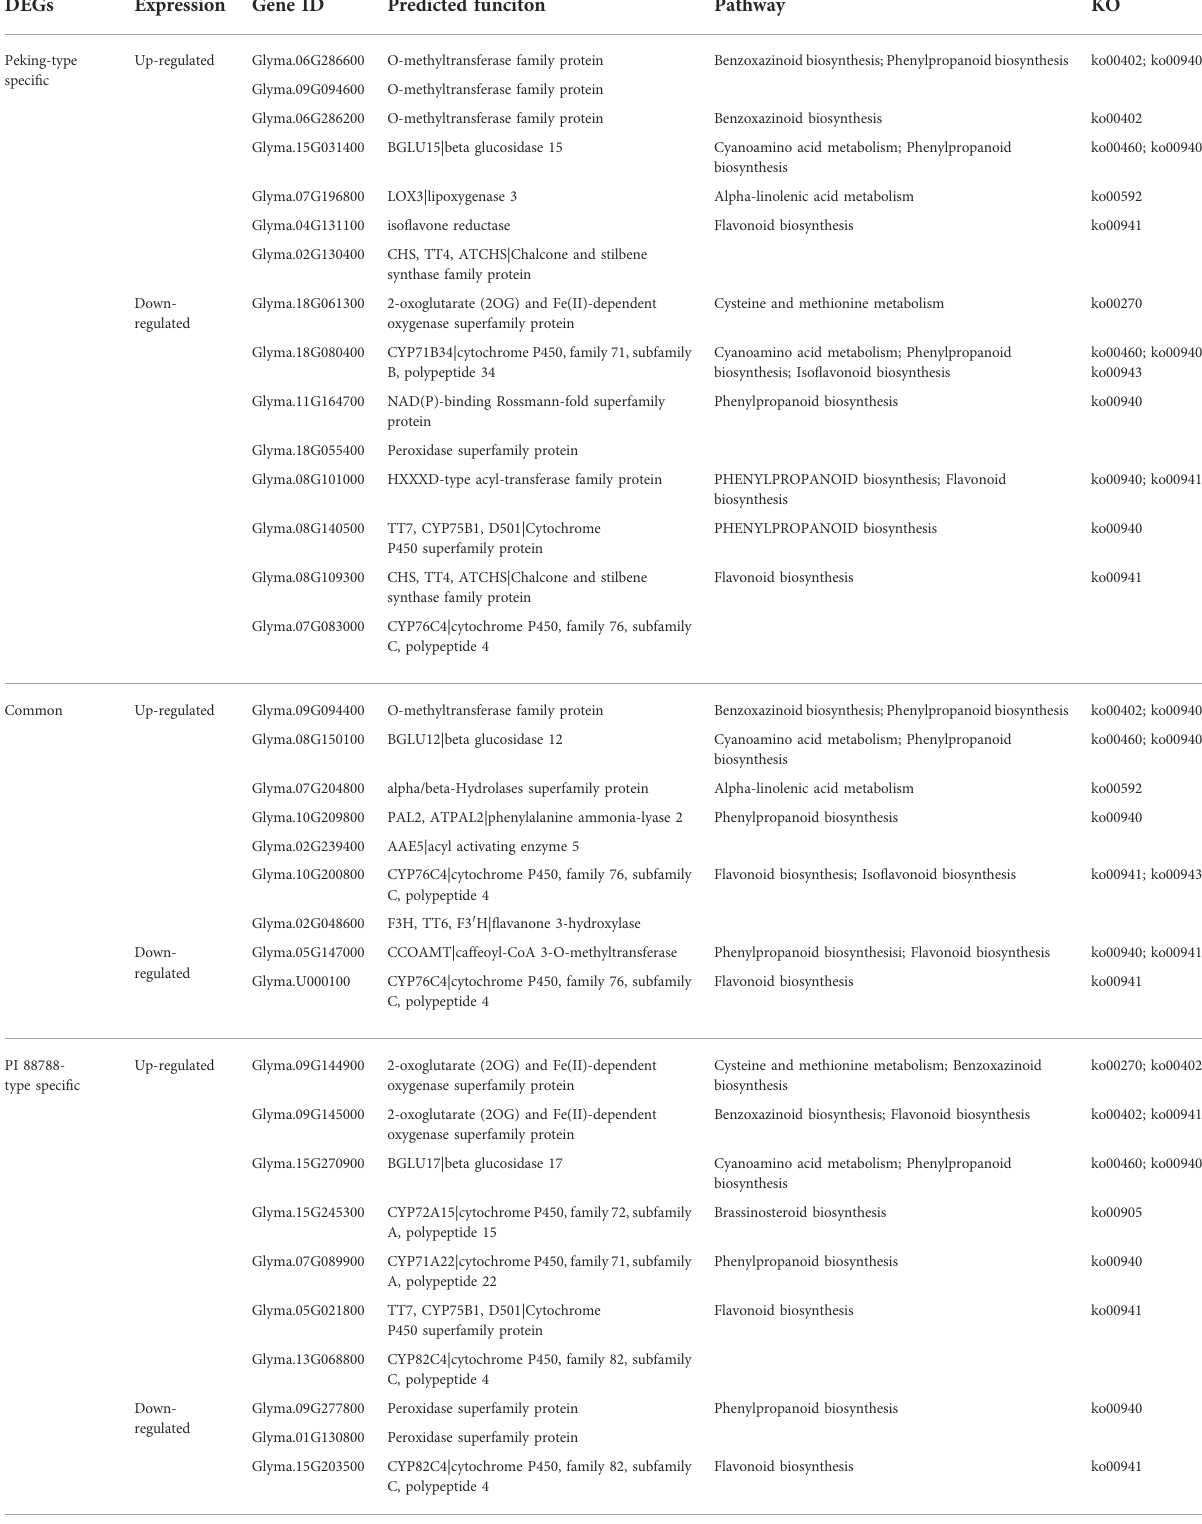
TABLE 3 The selected differentially expressed genes (DEGs) related to metabolites involved in constitutive resistances of Peking- and PI 8878- type sources of resistance (Pool-I and Pool-II).